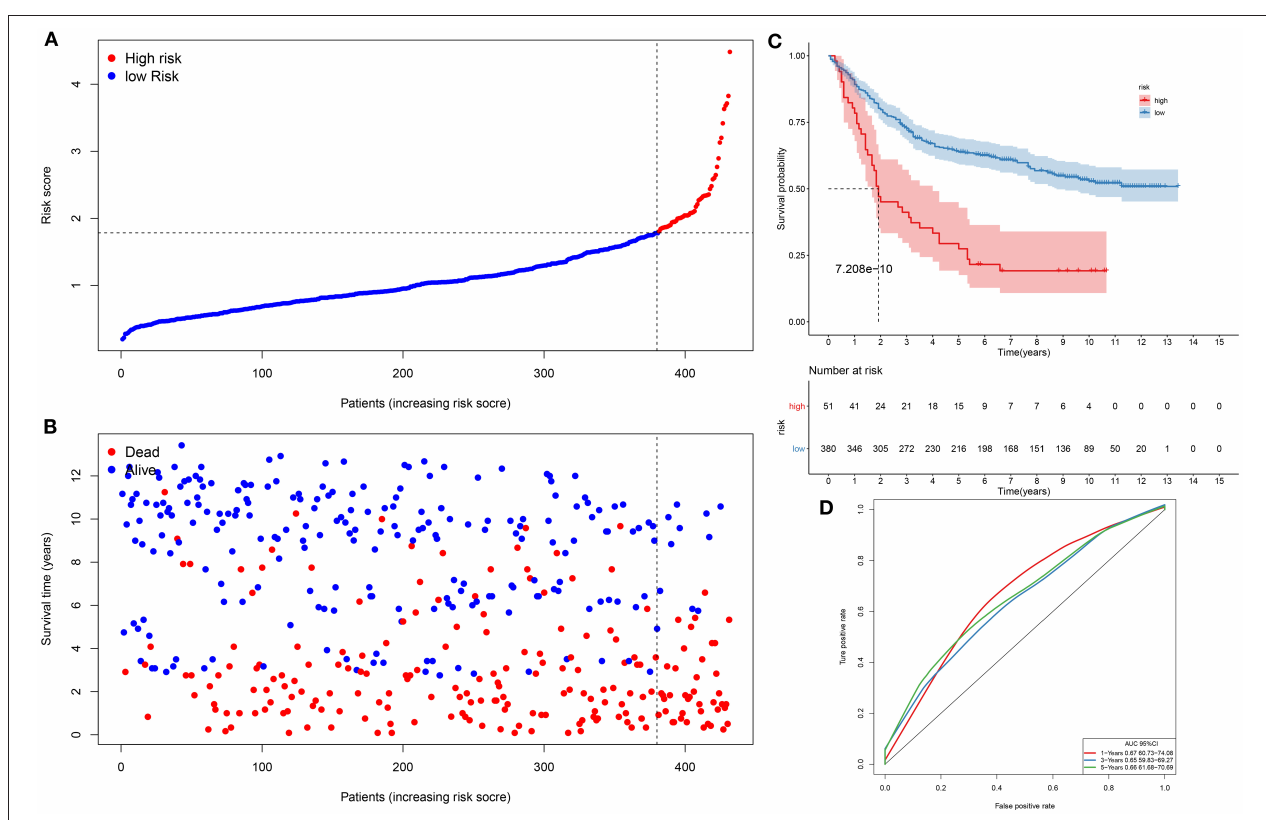
FIGURE 2 | Assessment of this prognostic signature in the verification dataset. (A) The ranking of risk scores, and (B) the distribution of survival status among gastric cancer samples. The vertical dotted line corresponds to the cutoff of risk scores. (C) Kaplan–Meier curves of clinical outcomes concerning high- and low-risk subjects. (D) ROCs of 1-, 3-, and 5-year